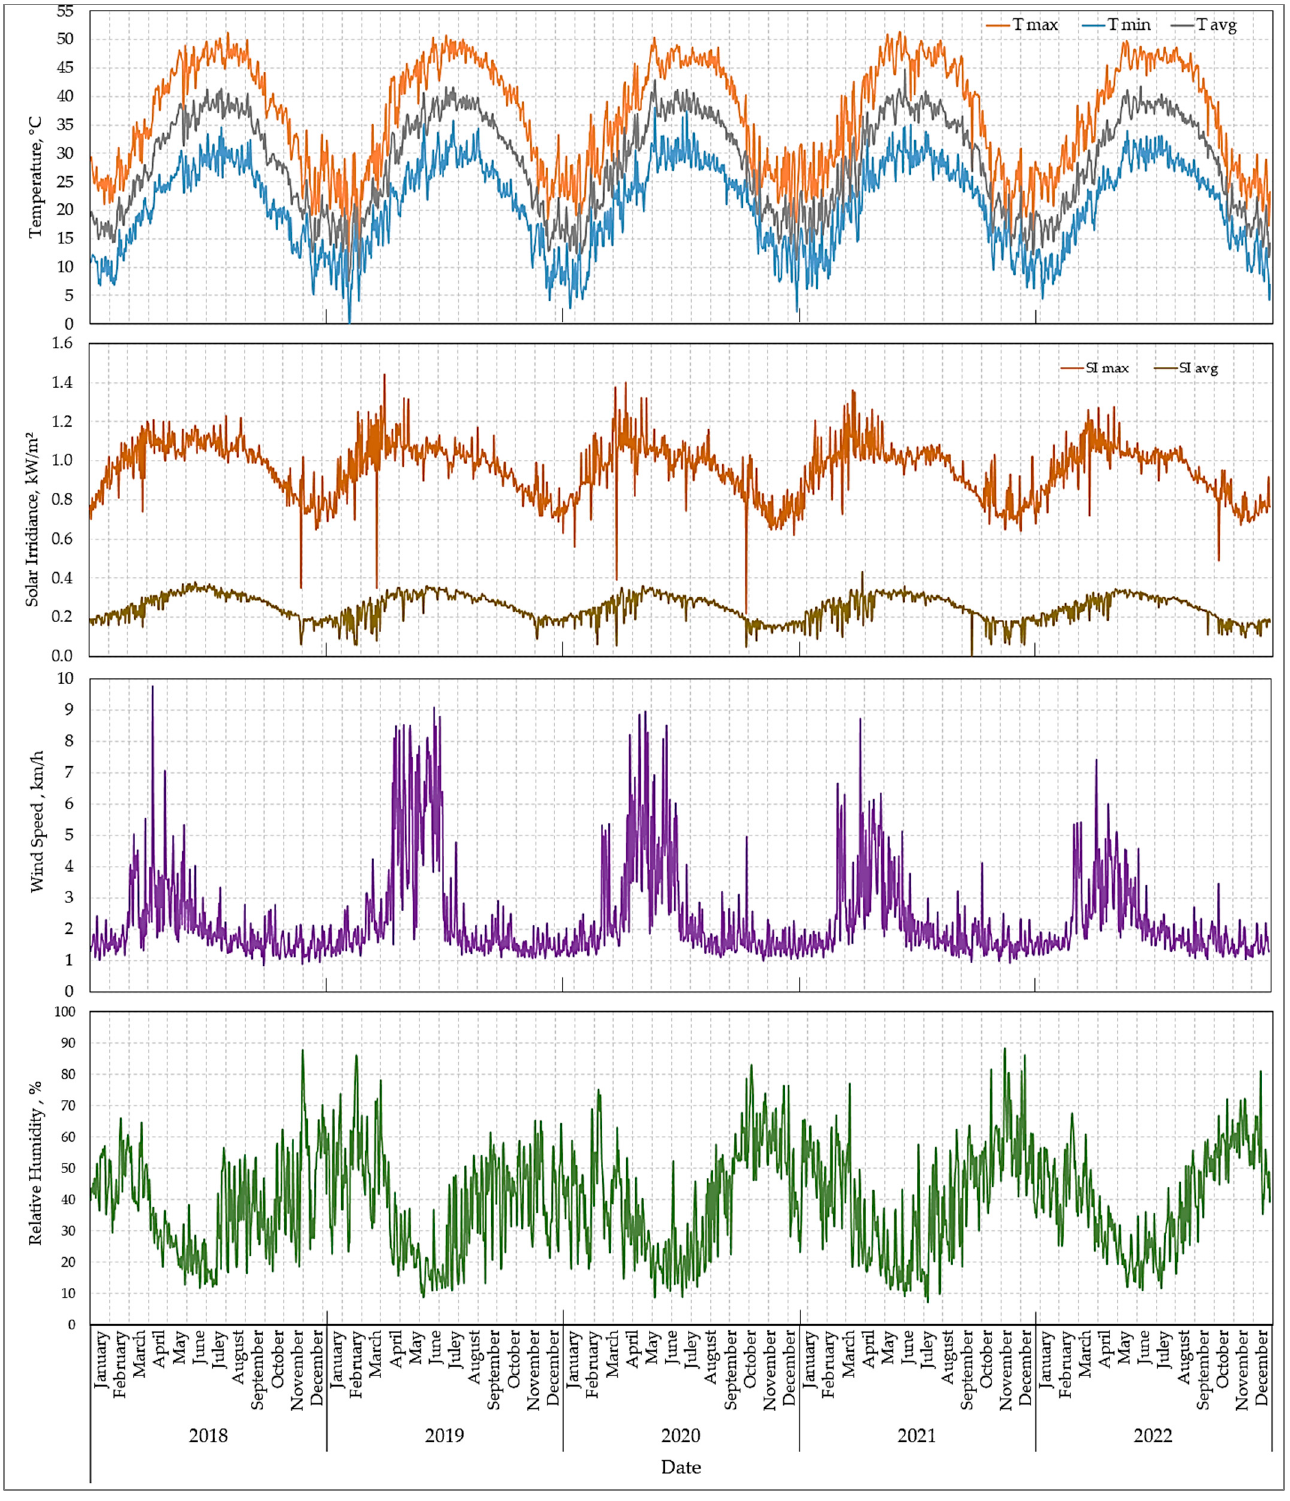
Figure A1. Average daily values of the maximum temperature (T max), minimum temperature (T min), average temperature (T avg), maximum solar irradiance (IR max), average solar irradiance (IR avg), average wind speed, and average RH for the five years from 1 January to 31 December 2022.